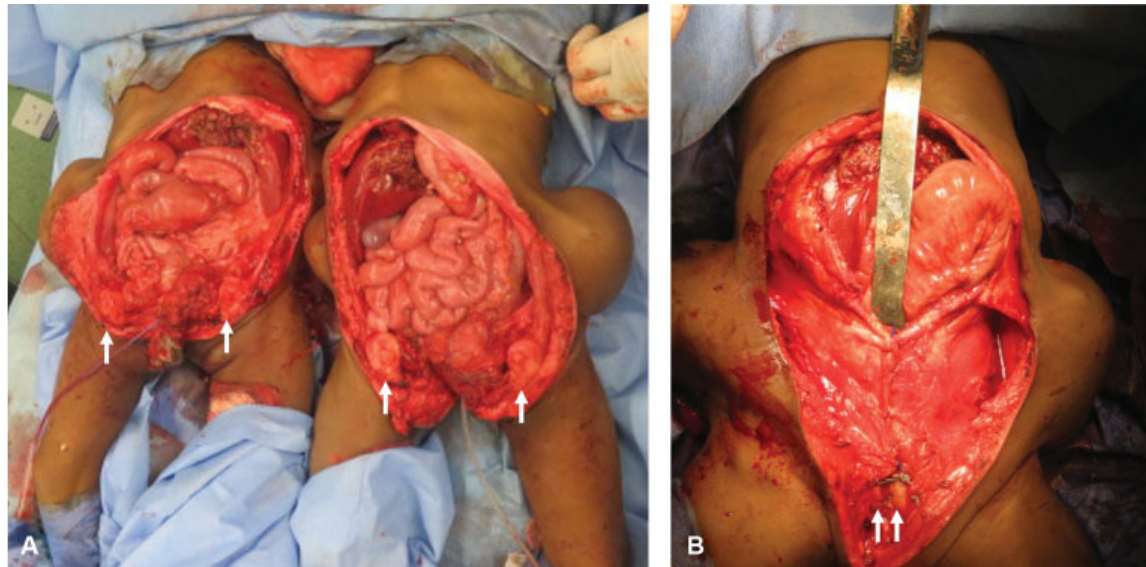
Fig. 7 The fi nalphaseaftercompleting theseparation ( A ) and starting closure of the abdomenforeachtwin ( B ).( A ) Thewhite arrows arepointing tothe pubicbonesthat werewidelyseparatedinbothtwins(pelvicdiastasis).( B )Approximationofpubicbonesinthemidlinefollowingiliacosteotomiestoassist in closing the abdomen. Note Retrieval of expanders was delayed near the end of operation just before closure of the skin.